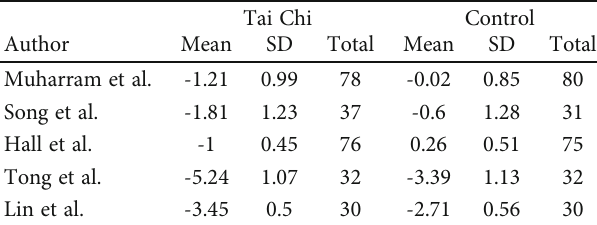
Table 2: E ff ect of Tai Chi for